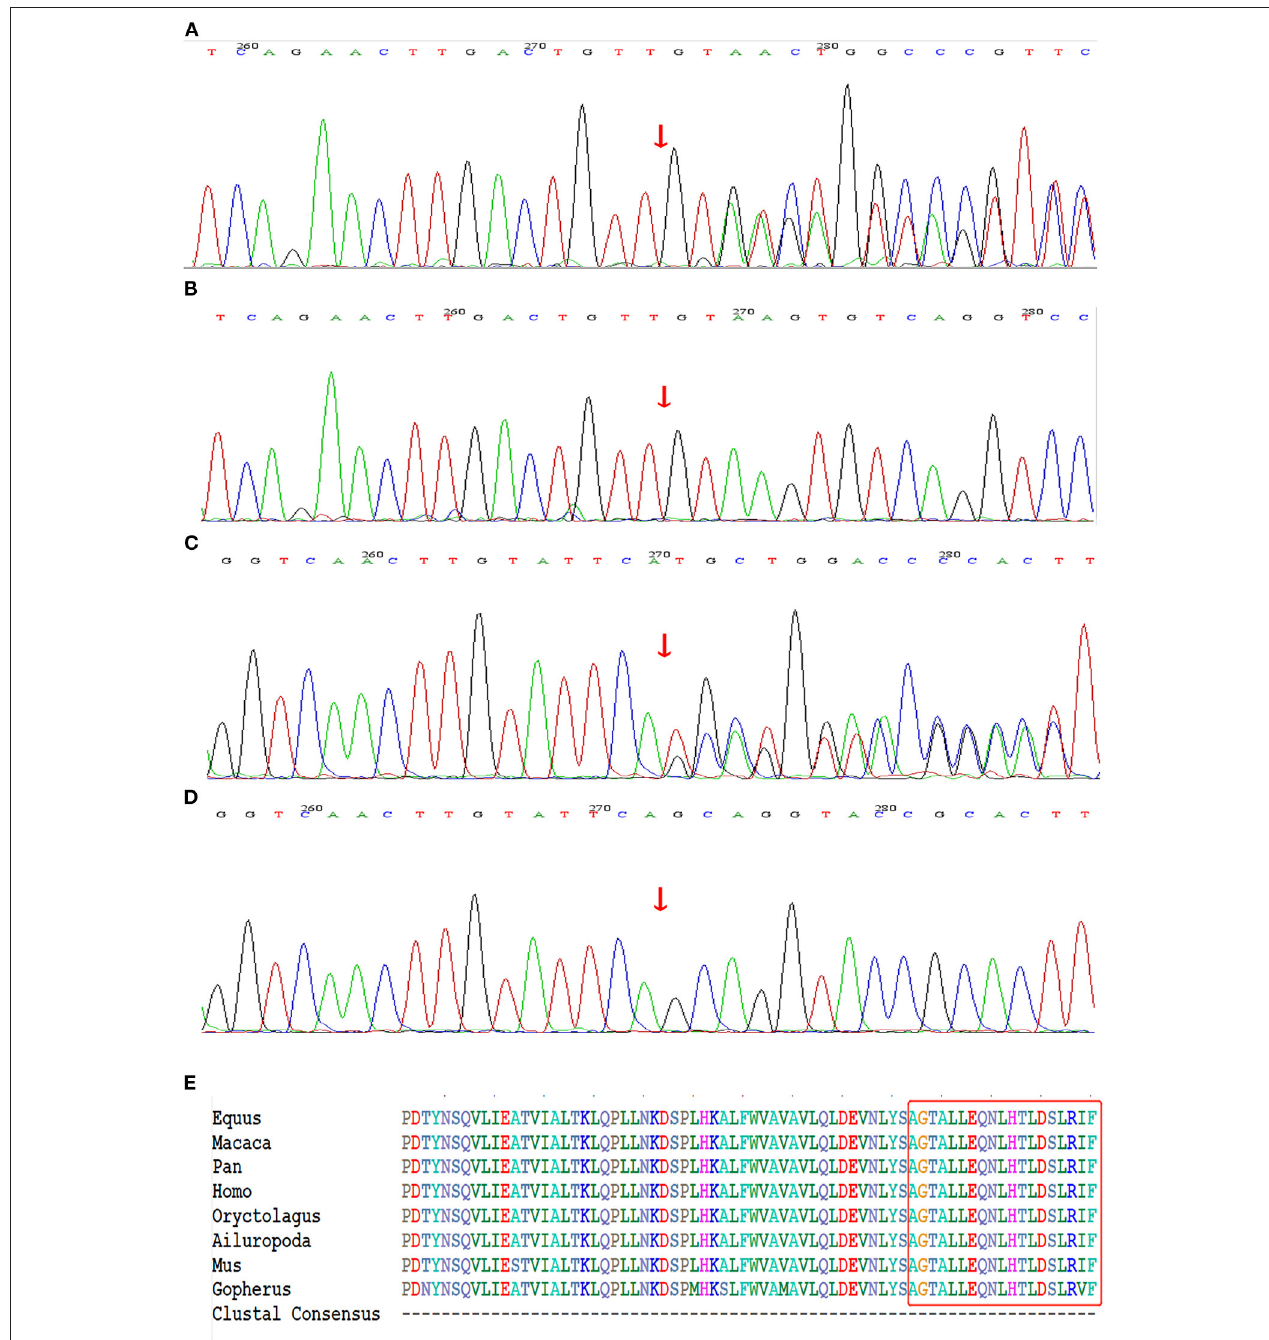
FIGURE 3 | Genetic sequencing results of NF1 gene. (A) The recurrent frame-shift mutation c.6789_6792delTTAC (arrow) found in the index patient of family 1. (B) Wild-type found in unaffected subjects of family 1. (C) The novel frame-shift mutation c.6934_6936delGCAinsTGCT (arrow) found in affected subjects of family 2. (D) Wild-type found in unaffected subject of family 2. (E) The mutation region of neurofibromin protein identified in family 2 is highly conserved by analyzing orthologs from 8 various species on CLUSTALW